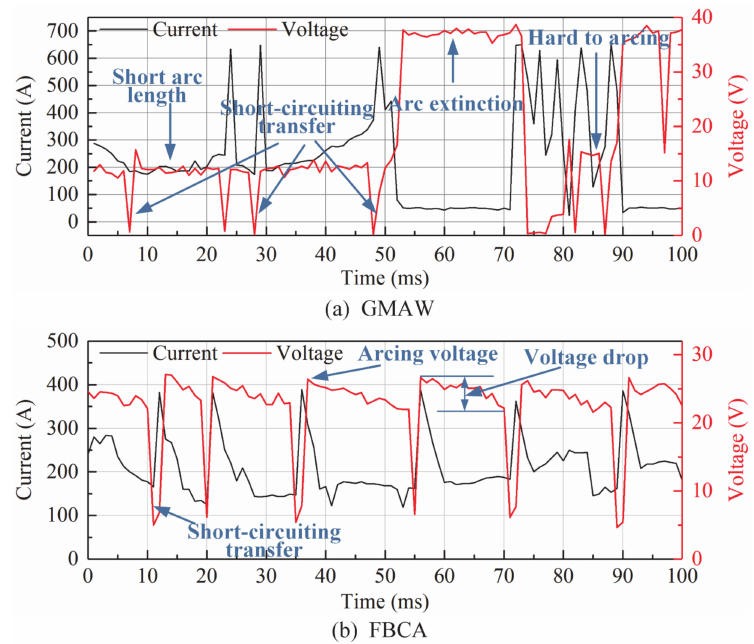
Figure 15. The dynamic characteristics of voltage and current in GMAW and FBCA welding process (welding current: 260 A, arc voltage: 24 V, welding speed: 7.5 mm / s, groove gap: 6 mm). ( a ) GMAW, ( b ) FBCA.